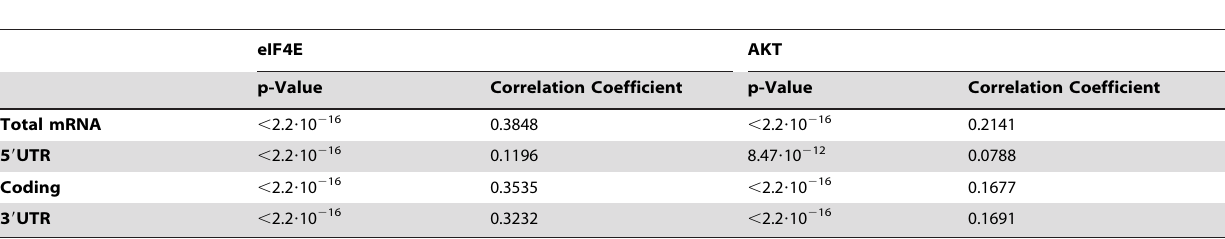
Table 1. G + C content shows correlation with polysome shift for total mRNA, coding and 3 9 UTR but not for 5 9 UTR sequence.